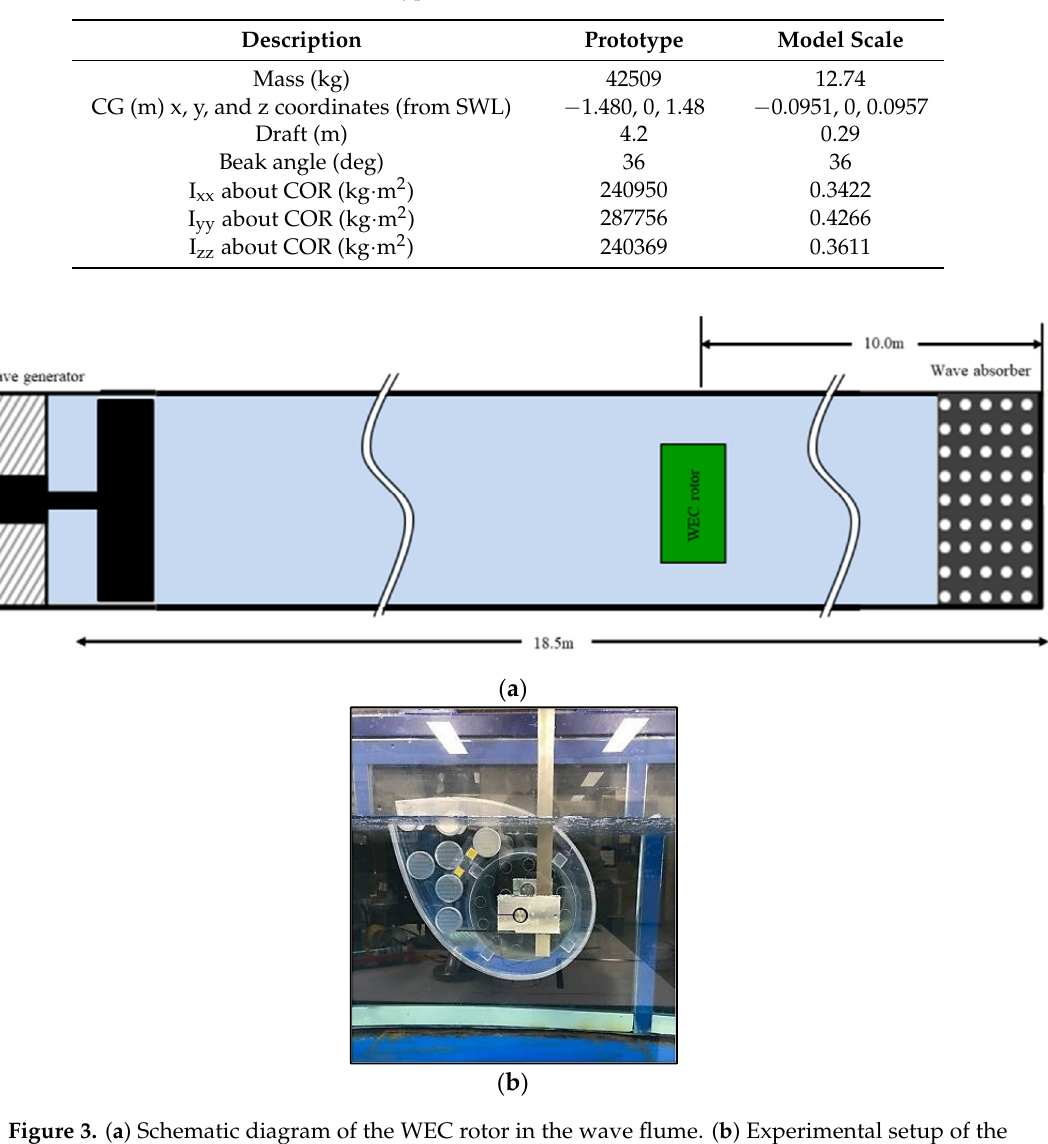
Table 2. Prototype and model details (Scale 1:14.8).